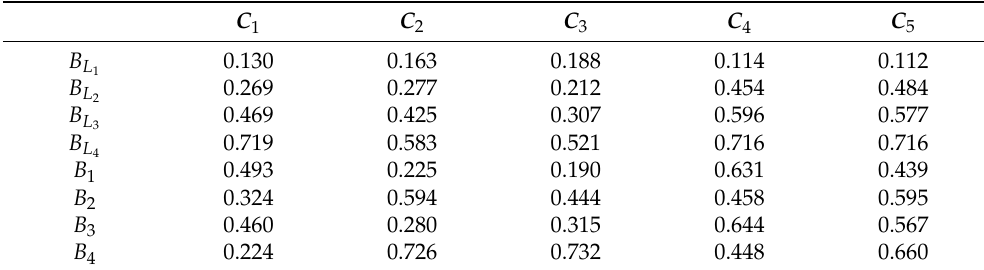
Table 7. Global preference score.